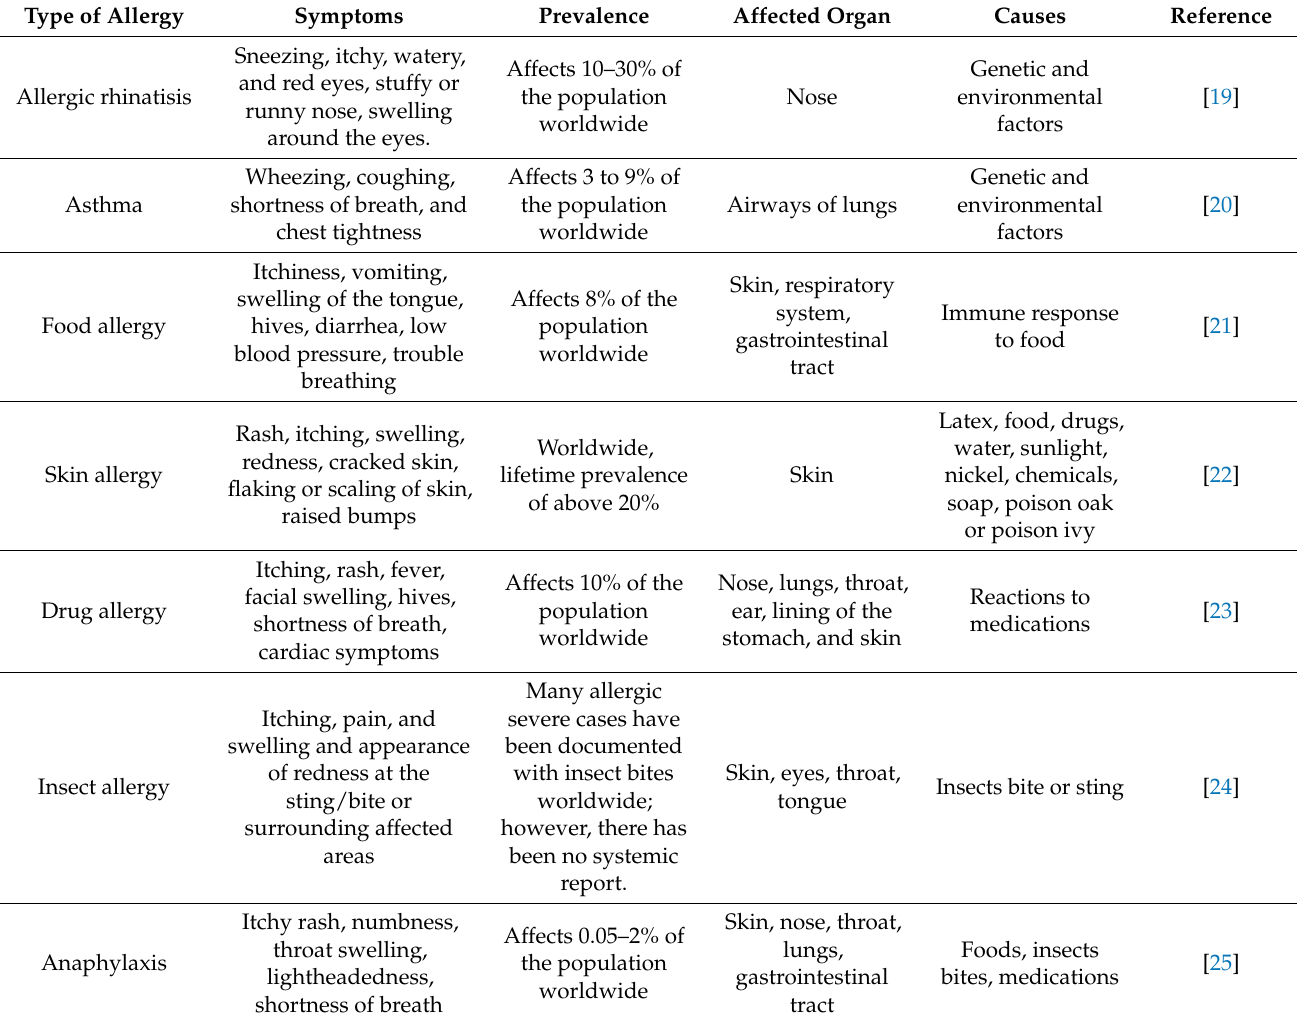
Table 1. Symptoms, causes, and prevalence of different allergy